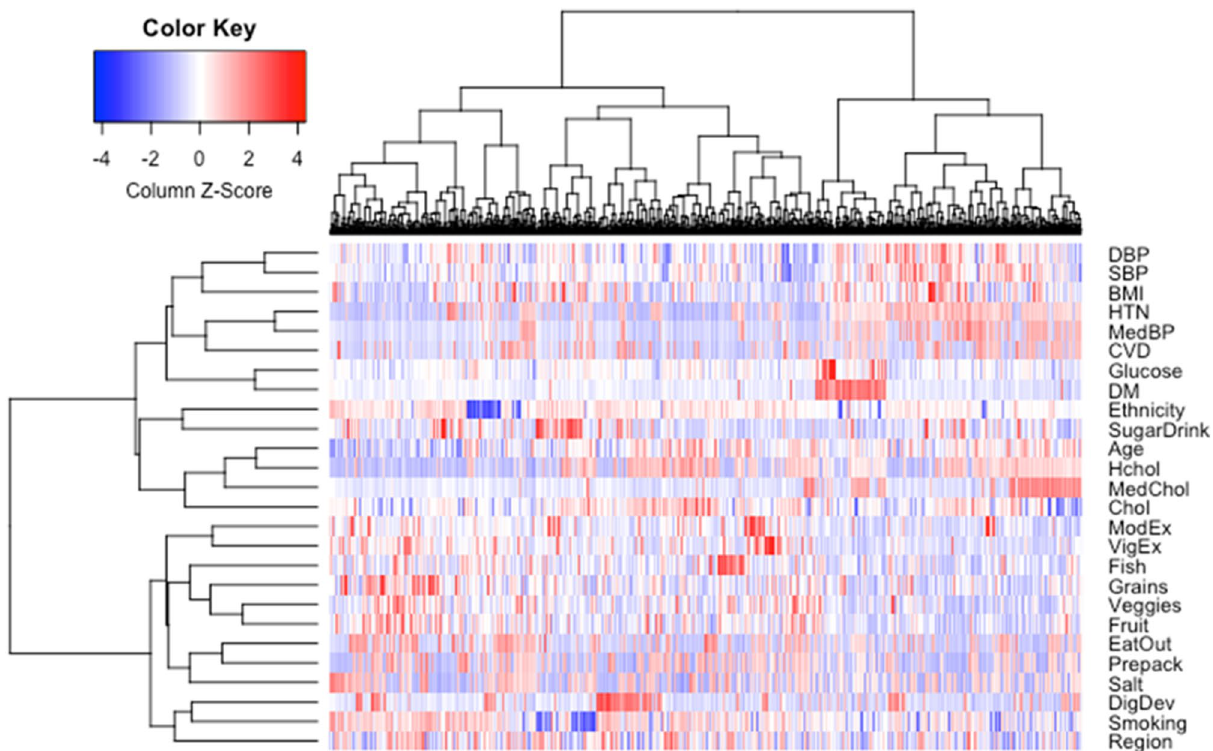
Figure 2. Heterogeneity among women. Hierarchical clustering of continuous and categorical variables derived from Life’s Simple 7 survey responses was performed to create a phenotype heatmap for women (n = 1,251) enrolled in the study. The heatmap reveals heterogeneity among women. DBP, diastolic blood pressure; SBP, systolic blood pressure; BMI, body mass index; HTN, hypertension; MedBP, takes medications for blood pressure; CVD, prior history of prior cardiovascular disease; DM, diabetes mellitus; SugarDrink, number of sugar-sweetened beverages; Hchol, hypercholesterolemia; MedChol, takes medications for cholesterol; Chol, total cholesterol; ModEx, weekly minutes of moderate exercise; VigEx, weekly minutes of vigorous exercise; Fish, servings of fish per week; Grains, servings of whole grains per day; Veggies, cups of vegetables per day; Fruit, cups of fruit per day; EatOut, avoid eating out; Prepack, avoid prepackaged foods; Salt, avoid added salt; DigDev, registered a digital health device; Smoking, smoking status; Region, region of the United